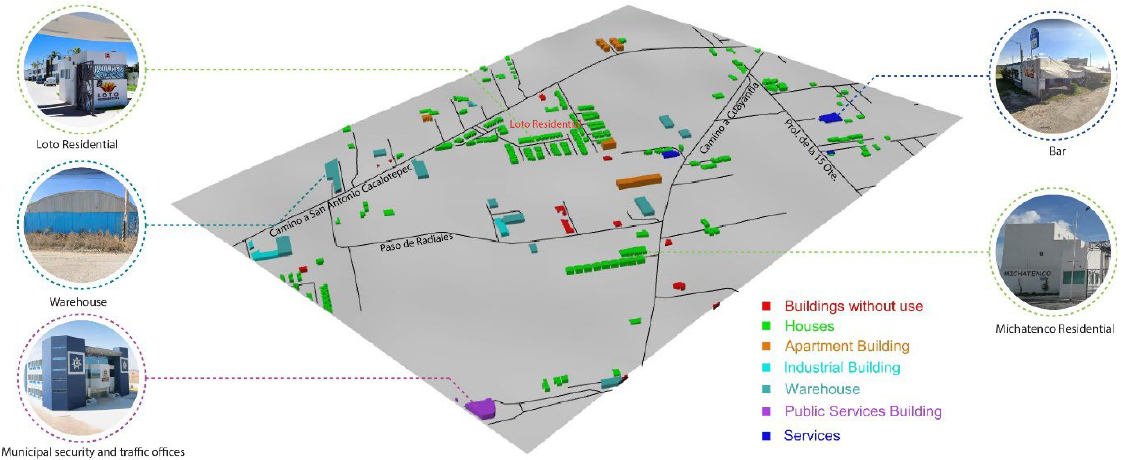
Figure 3. Outskirts of the San Rafael Comac rural community, demonstrating the territorial structure of the area of 1 km 2 outside the community center, between the streets of Camino a San Antonio Cacalotepec and Camino a Cuayantla. Elaborated by Edwin González M. (2022).